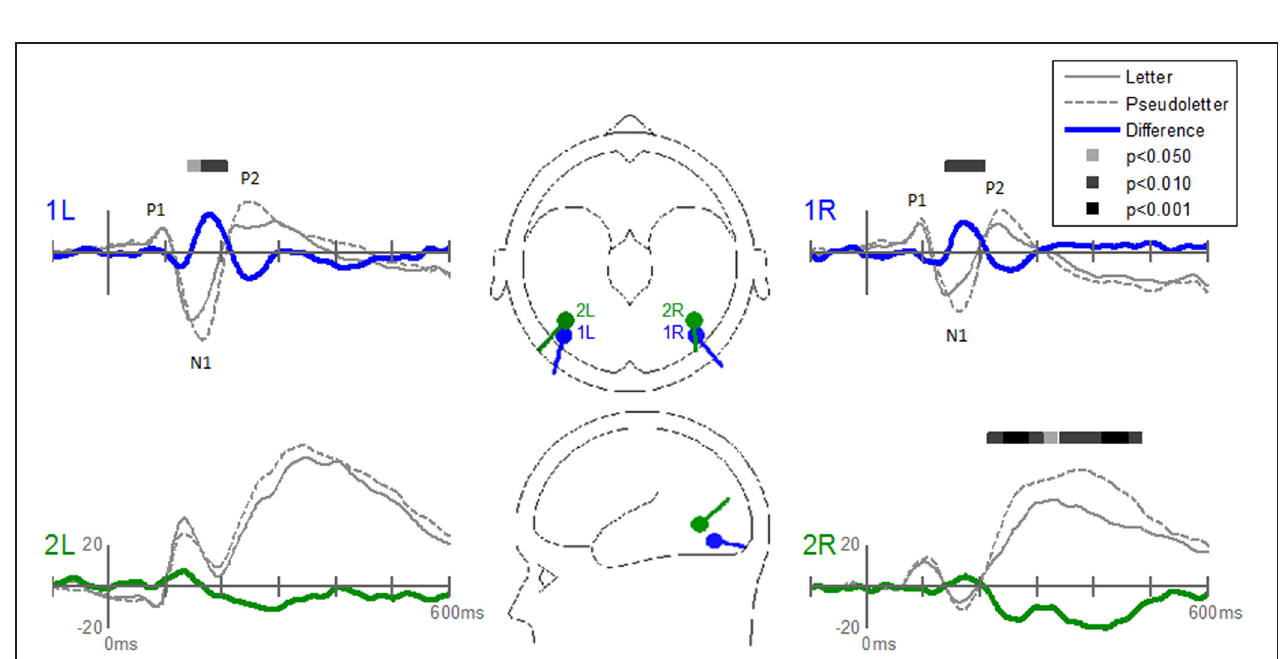
FIGURE 7 | Grand-mean source waveforms for the Interaction of Task by Stimulus for the Task-effects model (inset) with bilateral dipoles in the fusiform gyri (dipoles 1L and 1R), medial frontal gyrus (dipole 2), and medial lingual gyrus (dipole 3). Waveforms are plotted as the differences